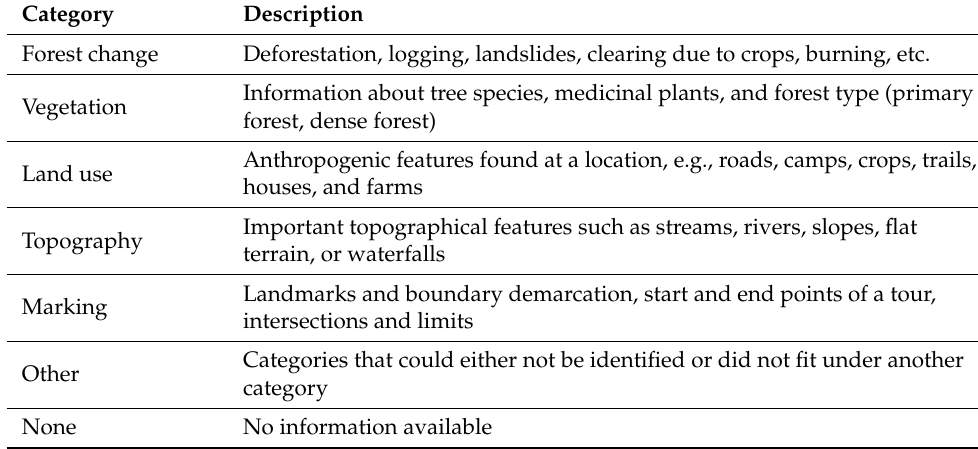
Table 1. Thematic detail of CBM observation